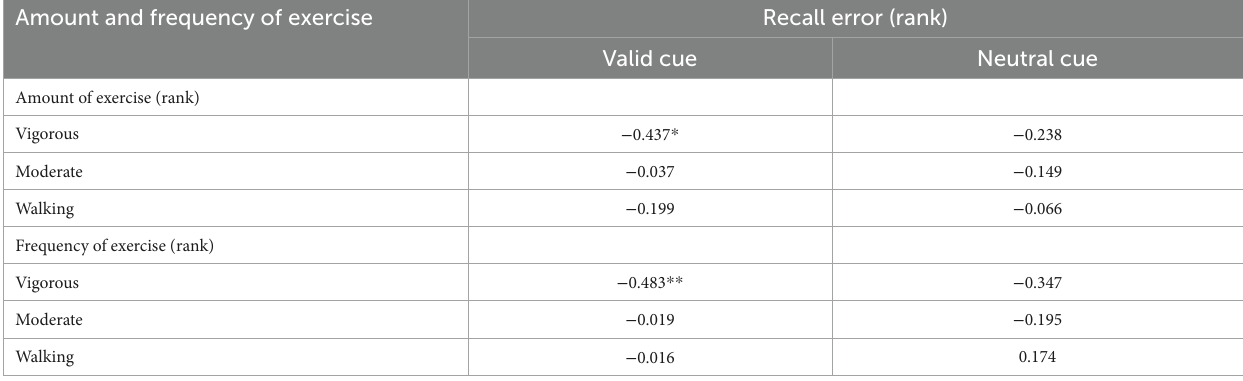
TABLE 2 Spearman correlation between exercise and recall errors in the full sample ( n = 30). Amount and frequency of